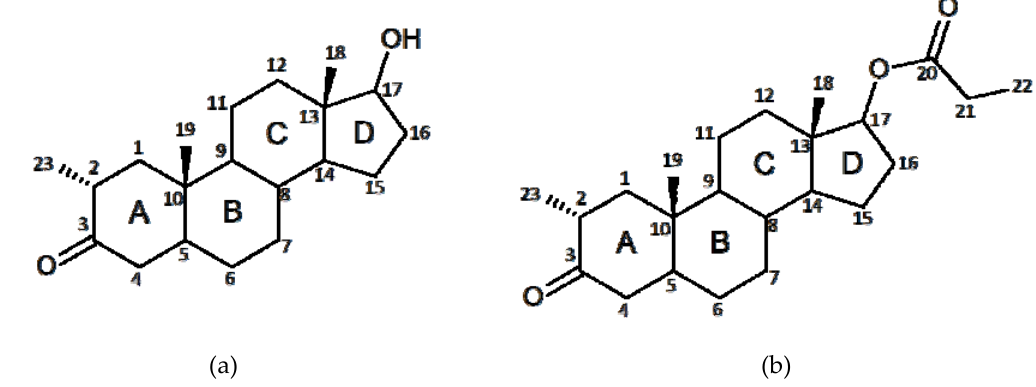
Figure 1. Chemical configurations of ( a ) drostanolone and ( b ) drostanolone propionate displaying the atom labeling system.